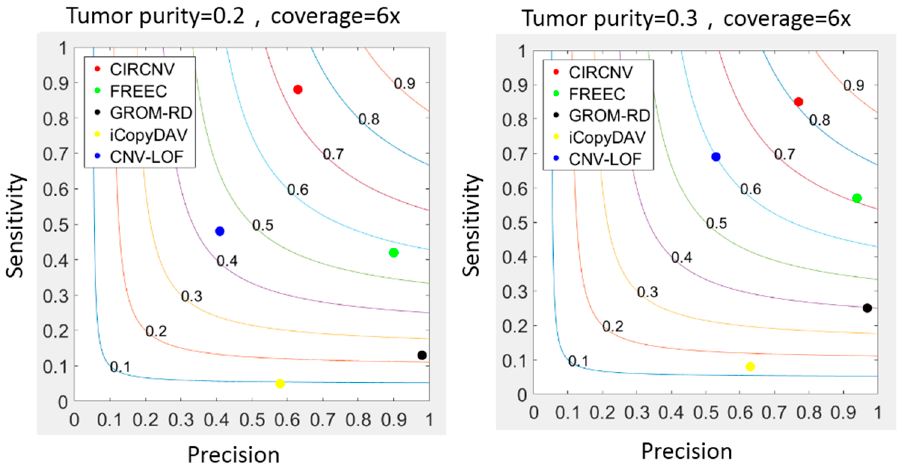
Figure 3. Comparisons between the CIRCNV method and four peer methods with respect to sensitivity, precision, and F1-score on simulation data. The color curves ranging from 0.1 to 0.9 denote the F1-scores.